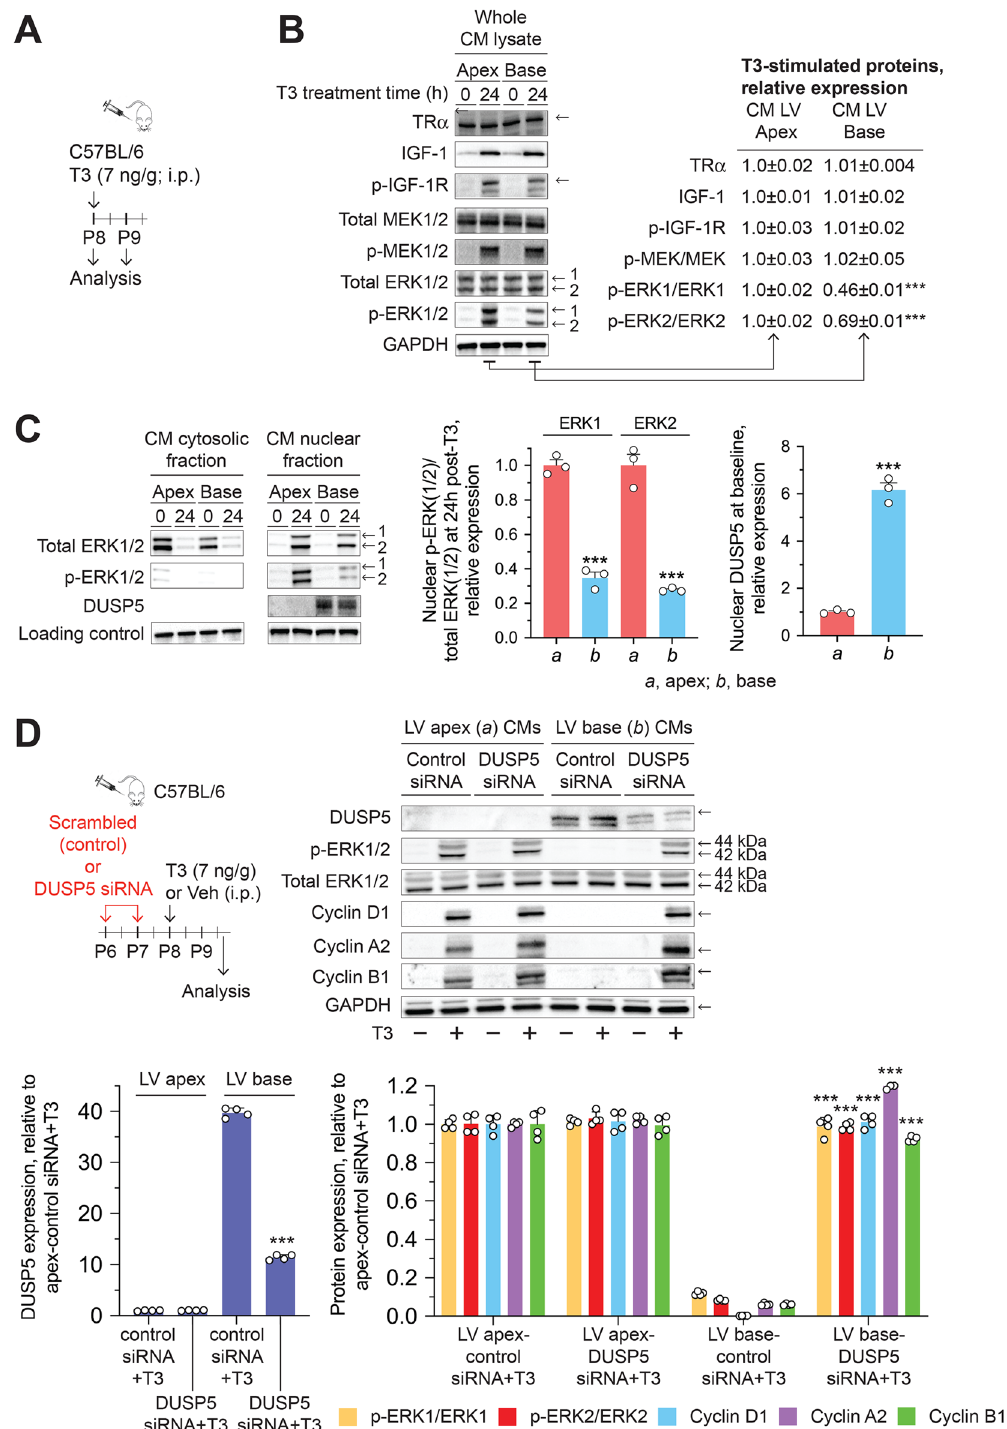
Figure 4. T3-induced ERK1/2 phosphorylation and cyclin expression in cardiomyocytes (CMs) of the P8 LV base is inhibited by DUSP5. ( A ) Schematic showing the protocol for T3 administration and analysis times. ( B ) Representative immunoblots show expression levels of indicated proteins in whole CM lysates obtained from CMs of the LV apex and base at 0 (baseline) and 24 h after T3 administration. Quantitative data relative to that obtained from analysis of CMs of the LV apex, are shown next to the immunoblots. ( C ) Using the same protocol as in A, isolated CMs were resolved into their constituent nuclear and cytosol fractions before immunoblot analysis. Quantitative data are shown in bar graphs adjacent to the immunoblots. In ( B , C ) immunoblots are representative of 4 biologically independent replicates. ( D ) DUSP5 or scrambled (control) siRNA was administered intraperitoneally (i.p.) to mice at P6 and P7, followed by T3 ( +) or vehicle (–) treatment at P8. siRNAs were dissolved in the in vivo-jetPEI and 10% glucose mixture. Forty hours later, CMs were isolated and whole cell lysates prepared. Lysates were then subjected to immunoblotting for the indicated proteins. Immunoblots are representative of 4 biologically independent replicates. Quantitative data are presented in the histograms. Data are mean ± SEM. *** P < 0.001 comparisons for intra-LV region derived cardiomyocytes from control versus DUSP5 siRNA treated